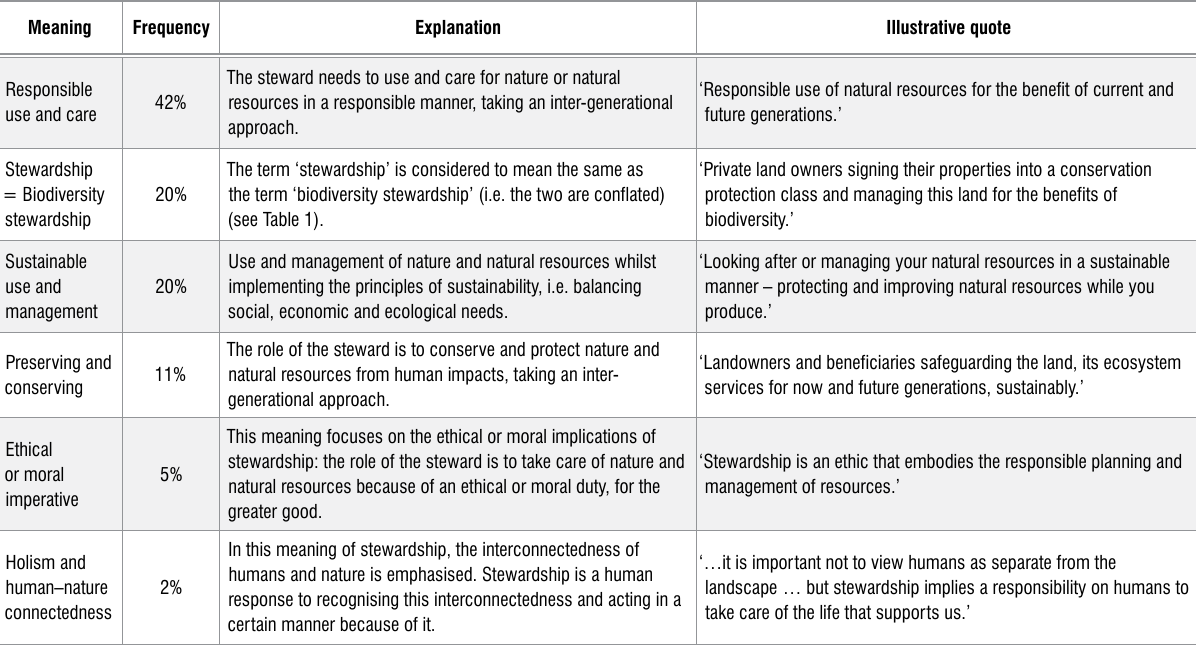
Word frequency counts from the responses of